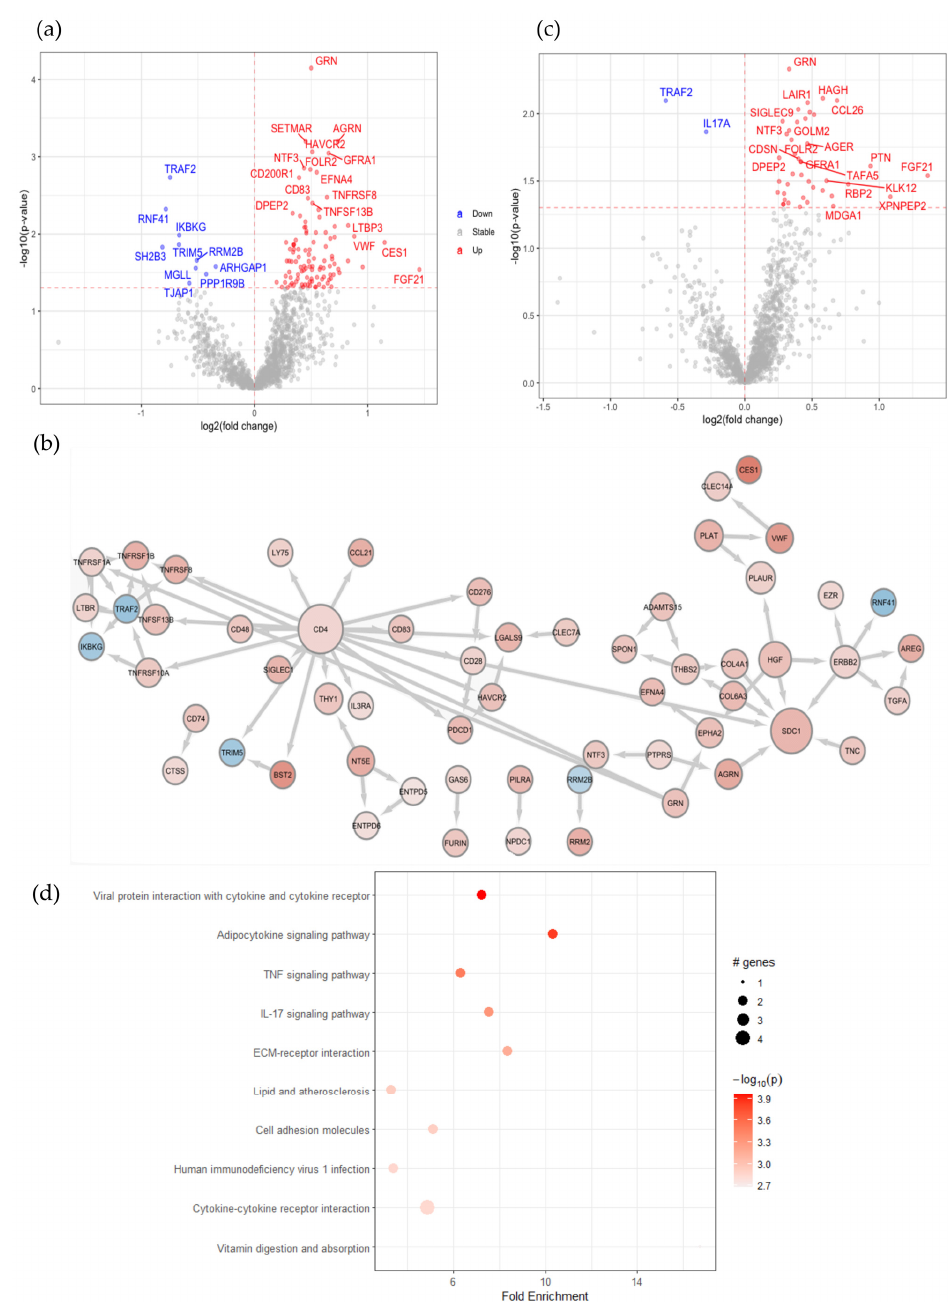
Figure 1. SARS-CoV-2 infection in patients with comorbidities causes plasma protein changes with enhanced soluble CD4 and associated proteins. ( a ) Volcano plot of statistical significance against fold-change of proteins between SARS-CoV-2 virus-infected patients with comorbidities and healthy controls. Colored dots indicate statistically differentially expressed proteins (DEPs); ( b ) protein– protein interaction network of DEPs between SARS-CoV-2 virus-infected patients with comorbidities and healthy controls with the organic layout from the STRING database query with a 0.7 confidence cut-off. The size of nodes indicates the degree of connectivity of the nodes; ( c ) volcano plot of statistical significance against fold-change of proteins between SARS-CoV-2 virus-infected patients with comorbidities and paired disease controls. Dots indicate statistical DEPs; ( d ) dot plot of KEGG pathway enrichment combined with STRING protein–protein interaction network analysis from DEPs between patients and disease controls. ( a – c ) The red and blue dots represent upregulation and downregulation in patients,